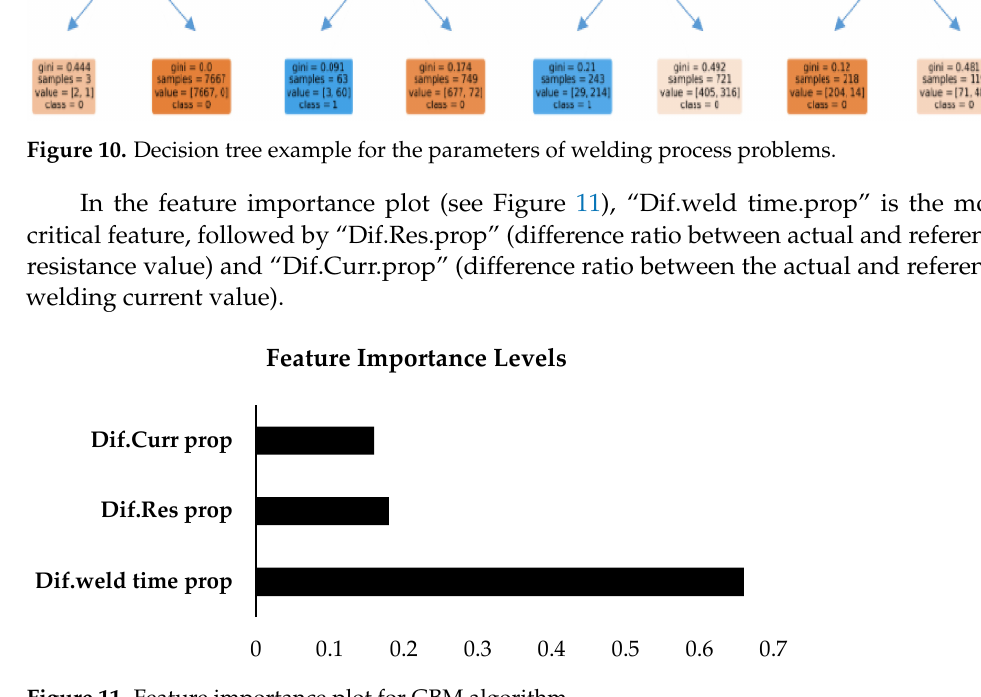
Figure 11. Feature importance plot for GBM algorithm.